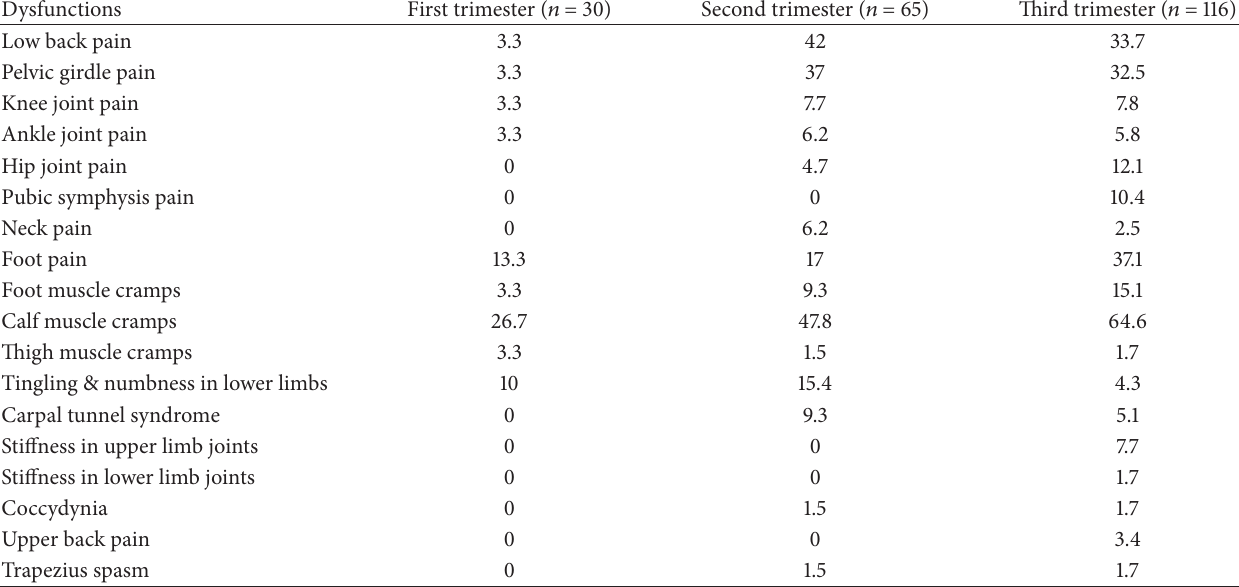
Table 1: Prevalence of musculoskeletal dysfunctions across trimesters in percentage (%).